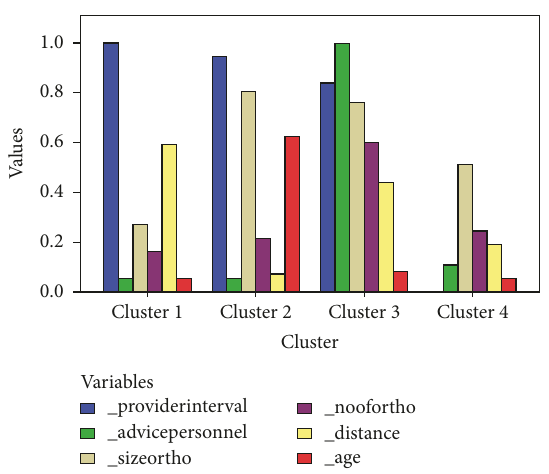
Figure 2: Comparison of proportions of clustering variables. Key. Provider interval: heightof bar represents the proportion of patients who stayed longer than 30 days in provider interval; advice per- sonnel: height of bar represents the proportion of patients who received incorrect advice; noofortho: height of the bar represents the proportion of patients who visited more than one personnel member; distance: height of the bar represents the proportion of patients who lived driving distance > 60min; sizeortho: height of the bar represents the proportion of patients who had tumors smaller than3cm; age:heightof thebar representsthe proportion of patients below 40